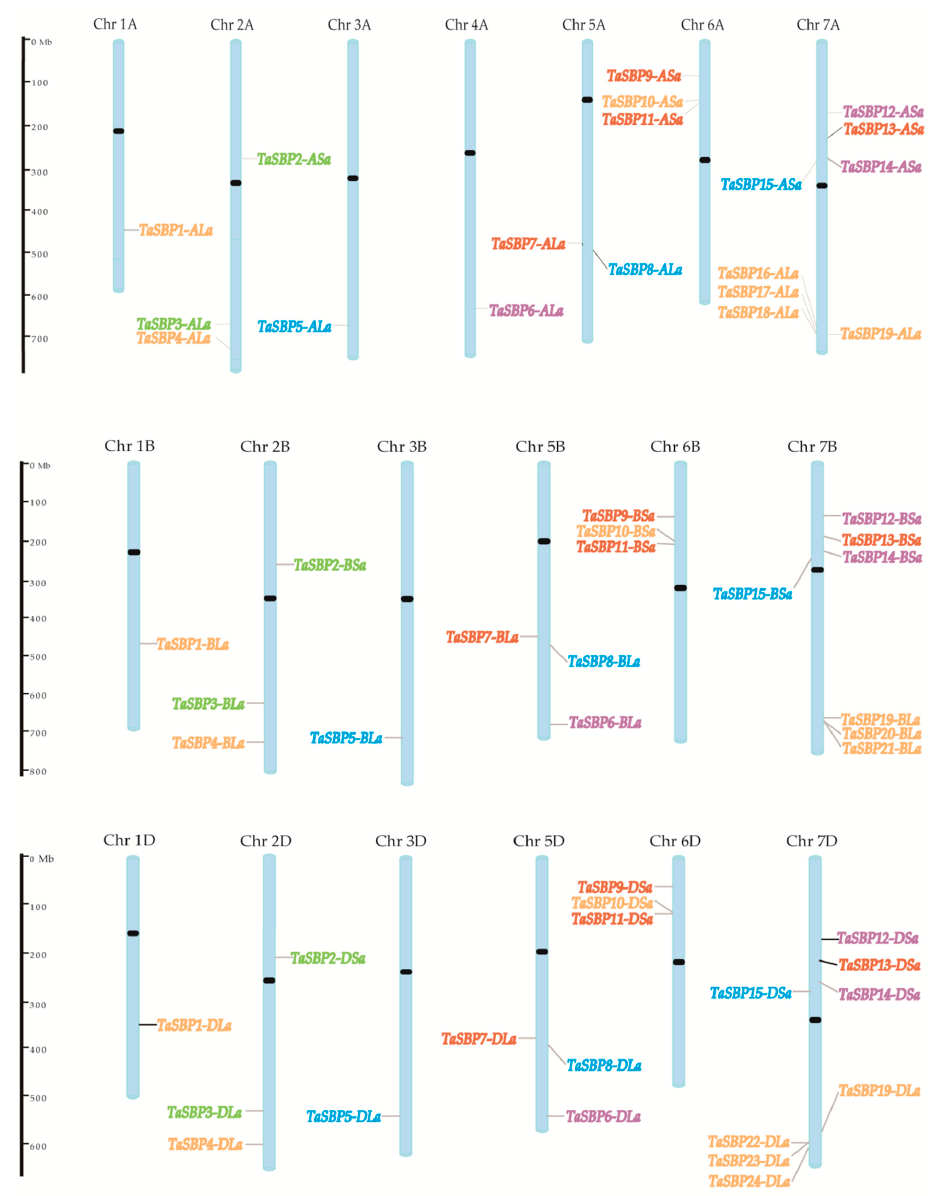
Figure 3. Chromosomal localization of the TaSBPs . The light blue column represents the chromosome and the black dots represent the centromere. Di ff erent groups of SBPs are represented in di ff erent colors. Blue represents Group I, purple represents Group II, orange represents Group III, green represents Group IV, and red represents Group V. In addition, Chr represents Chromosome.